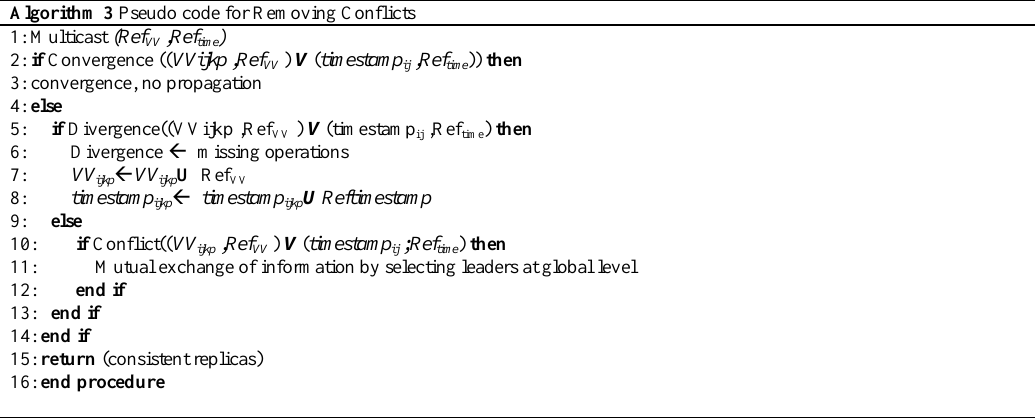
Algorithm 3 Pseudo code for Removing Conflicts 1: Multicast (Ref VV ,Ref time )